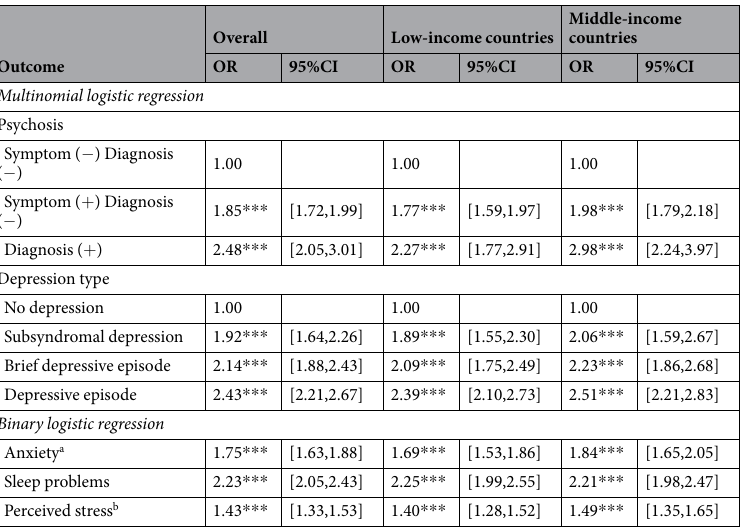
Table 4. The association between arthritis and mental health outcomes estimated by multinomial and binary logistic regression. Abbreviation: OR odds ratio; CI confidence interval. All models are adjusted for sex, age, education, wealth, setting, smoking, alcohol consumption, angina, asthma, diabetes, BMI, and country. Turkey is not included in the regression analyses as it lacked information on education. a Morocco is not included as it lacked information on anxiety. b Brazil, Hungary, and Zimbabwe are not included as they lacked information on perceived stress. *** p <